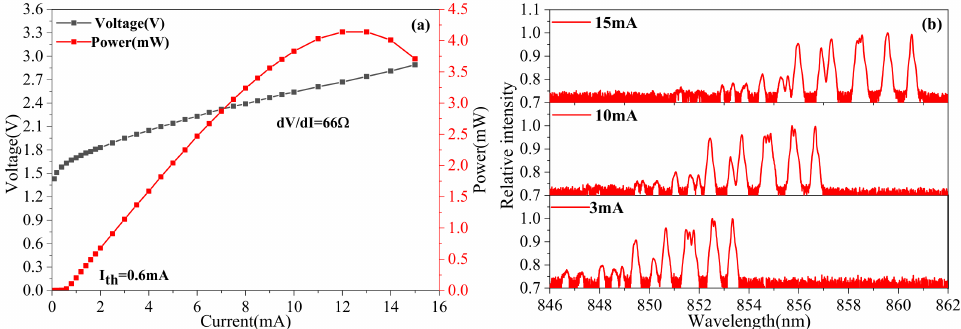
Figure 2. ( a ) L-I-V curves of the VCSEL with a 3 µ m oxide aperture, and ( b ) lasing spectra at different bias currents.